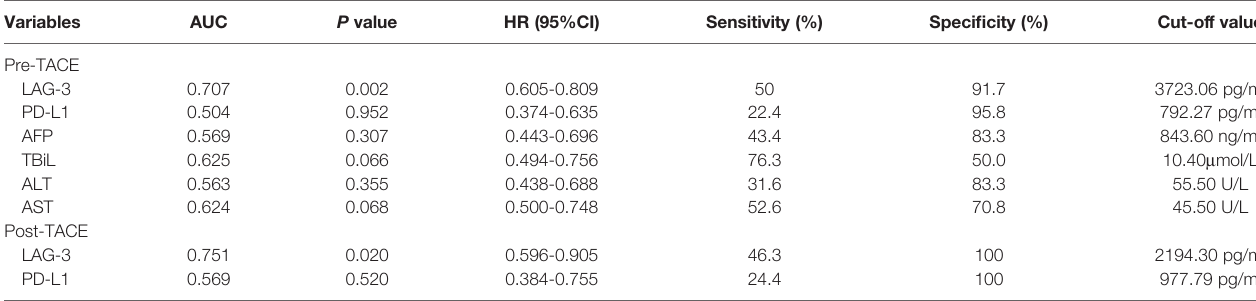
FIGURE 2 | Pre-TACE LAG-3 level as a serum indicator for predicting OR after TACE. (A) Pre-TACE serum levels of LAG-3 were signi fi cantly lower in patients who showed an OR to TACE compared to non-OR patients; (B) Pre-TACE serum levels of PD-L1 were unaltered between OR and non-OR patients; (C) ROC curve analysis of different variables for the discrimination between OR and non-OR patients. OR, objective response; non-OR, non-objective response. TABLE 2 | Discriminant abilities and the optimal cut-off values of the variables examined.